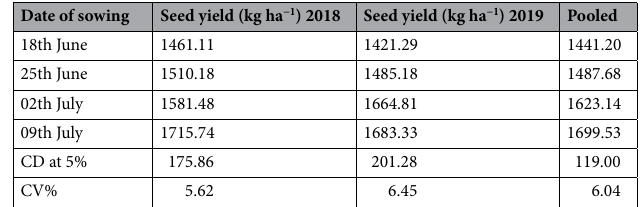
Table 7. Effect of sowing dates on grain yield of soybean (cv. RKS-24) during Kharif 2018 and 2019. *Mean of three replications.